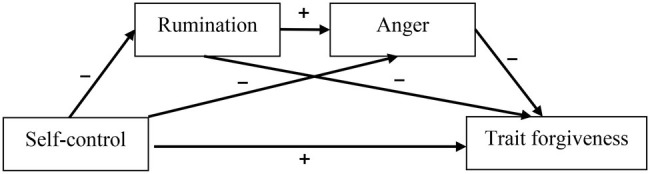
Conceptual model.